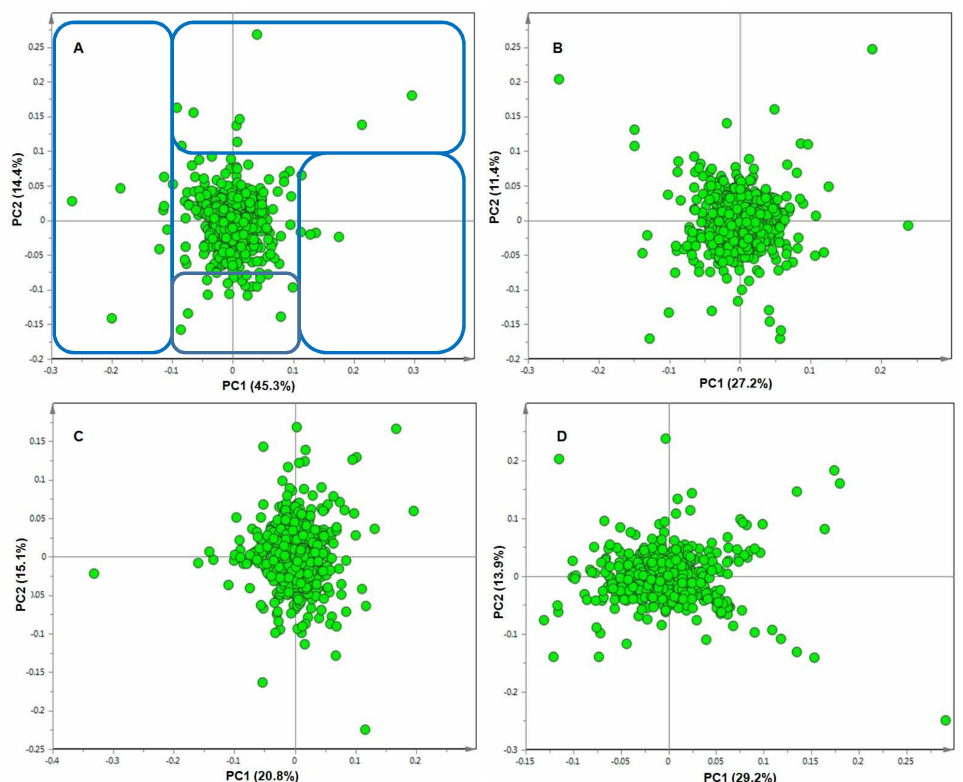
Figure 5. Principal component analysis (PCA) loadings plots of negative ionisation data for the susceptible ( S ) tomato plants. Shown are the metabolites (or biomarkers) responsible for the di ff erential clustering (highlighted in the blue boxes) seen on the scores plots of the di ff erent treatment groups at ( A ) day 8, ( B ) day 15, ( C ) day 25 and ( D ) day